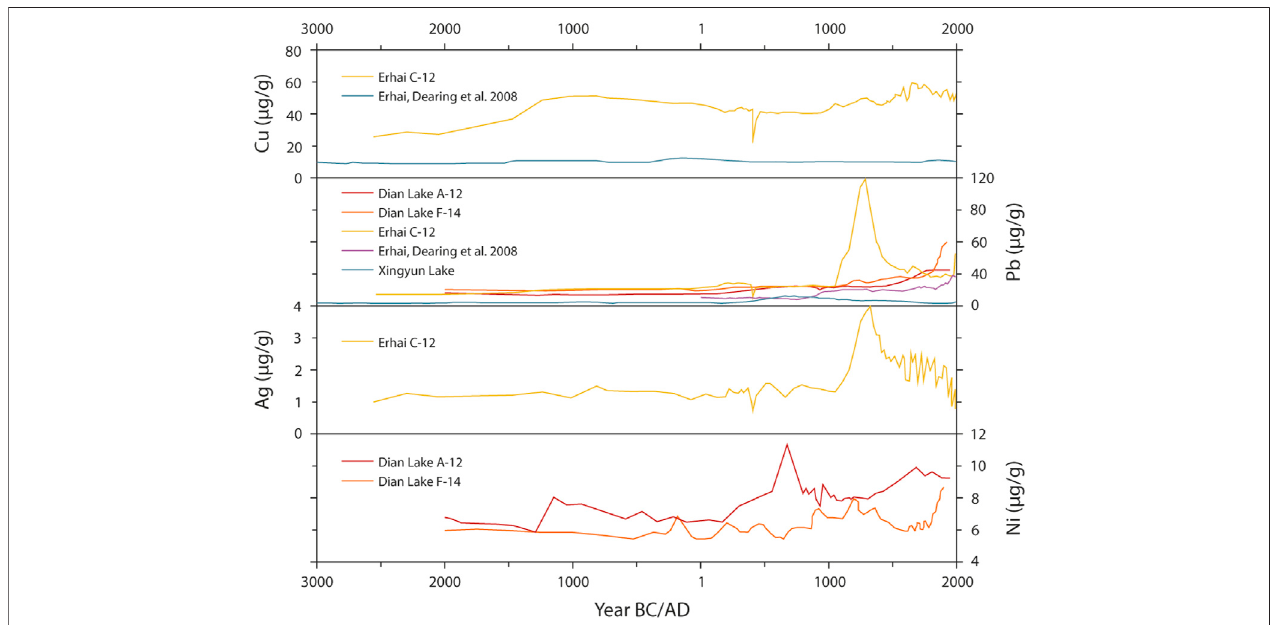
FIGURE3| SynthesisofmetalpollutiondatainancientYunnan (modi fi edfromHillmanetal.(2019);Hillman etal.(2015);Hillmanetal.(2014);Dearingetal.(2008)).